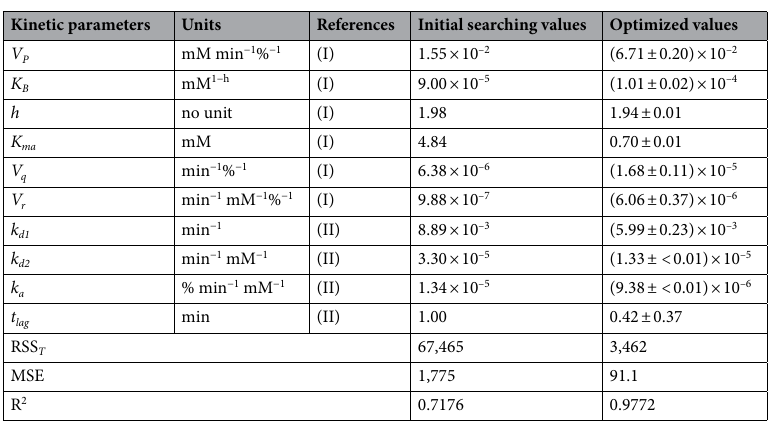
Table 2. Initial searching values and optimized values of kinetic parameters with corresponding RSS T , MSE, and R 2 of PAC biotransformation model for partially purified C. tropicalis TISTR 5350 PDC using initial substrates (pyruvate and benzaldehyde) concentration levels of (30/36) and (100/ 120) mM as well as initial volumetric enzyme activity between 1.1 and 1.5 U mL −1 . (I): Initial rate and batch biotransformation kinetics studies by Leksawasdi et al. 18,19 whose values were averaged and the relevant enzyme activity unit was normalized to relative percentage; (II): Benzaldehyde deactivation kinetics with inorganic phosphate buffer activation effect by Khemacheewakul et al. 34 . Full name of each parameter was given in nomenclature section.